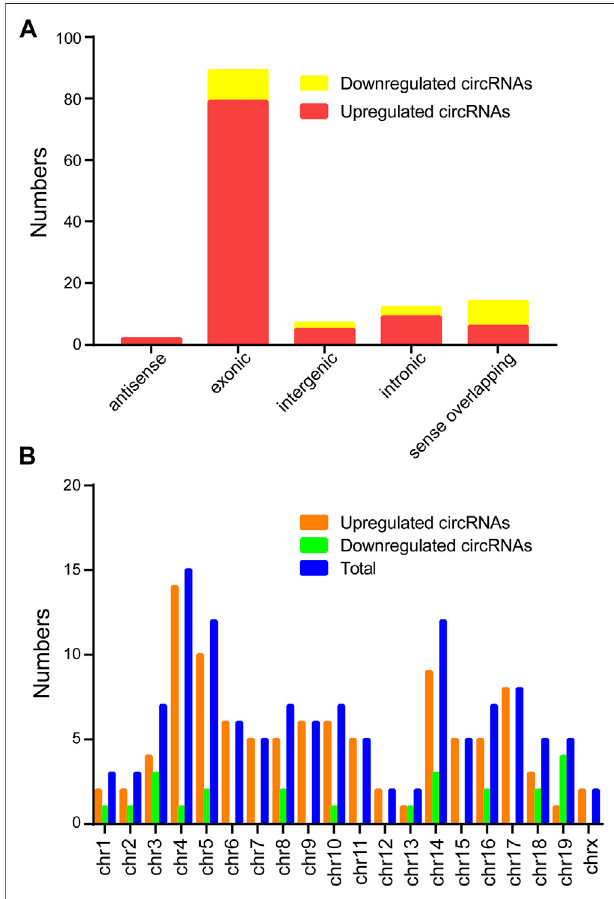
FIGURE 2 | Classi fi cation and distribution of the differentially expressed circRNAs. (A) Classi fi cation of the altered expressed circRNAs was listed. (B) The number of altered expressed circRNAs was determined in each chromosome.